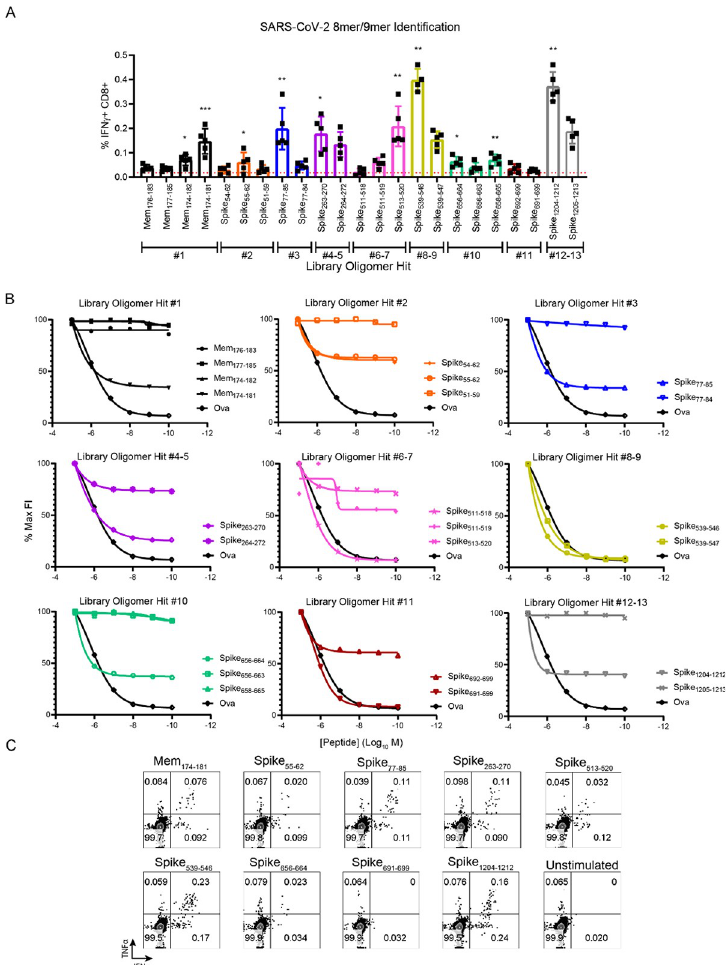
Fig 6. Identification of optimal 8-mer and 9-mer peptide epitopes. ( A ) T cell response to 8-mer or 9-mer peptides. Multiple SARS-CoV-2 8-mer or 9-mer peptide variants from each potential library hit were identified and purchased based on known K b or D b anchor residues. Five days post boosted infection with SARS-CoV-2 following transfection with hACE2 mRNA, splenocytes were harvested and stimulated for 6 hours with each peptide in the presence of brefeldin A. After stimulation, cells were stained for flow cytometry to evaluate the frequency of responsive CD8 + T cells by IFN- γ expression. Each color is indicative of a peptide variant being derived an individual potential library hit. ( B ) K b RMA-S stabilization assay. To determine relative ability of individual peptide variants to stabilize the K b molecule, decreasing concentrations of each peptide variant were incubated for 4 hours with TAP deficient RMA-S cells at 29 degrees C before being moved to 37 degrees C for 1 hour. Cells were then stained for either K b or D b with fluorescently conjugated antibodies and geometric mean fluorescent intensity (gMFI) was measured using an Atttune focusing flow cytometer. Fluorescence index (FI) was determined by dividing the gMFI of cells pulsed with peptide by cells with no peptide. Data is presented as a percentage of the maximum FI for each peptide. As a positive control, the K b restricted peptide Ovalbumin (SIINFEKL) was used. ( C ) Representative cytokine responses to each optimal epitope of mice transfected with hACE2 and infected with SARS-CoV-2 five days post boost. splenocytes five days after SARS-CoV-2 boost. The response to each potential optimal epitope was determined by IFN- γ production by CD8 + T cells compared to cells stimulated with vehi- cle ( Fig 6A ). We were able to detect responses above background in all 8-mer or 9-mer vari- ants evaluated. Interestingly, in some cases multiple variants of the same core library sequence had statistically significant CD8 + T cell responses compared to vehicle stimulated wells, sug- gesting that in some cases more than one peptide variant could be used to achieve T cell